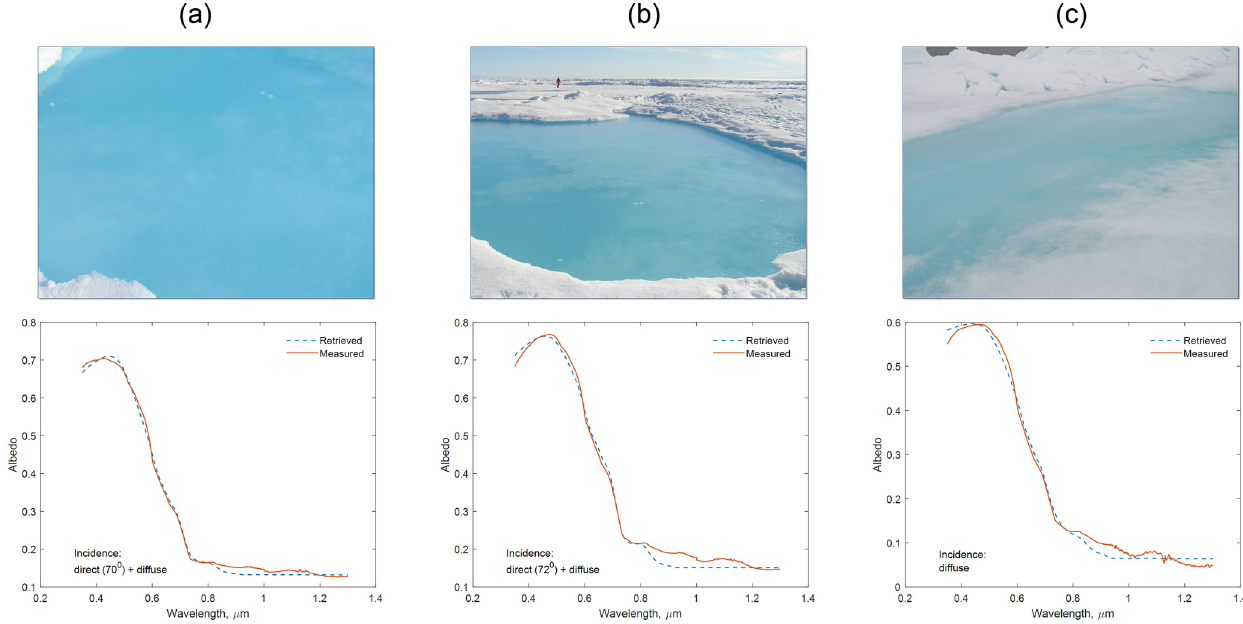
Figure 6. Light frozen (2–3cm layer of ice) blue ponds. Polarstern-2012, Stations 1 (a, b) and 3 (c) .